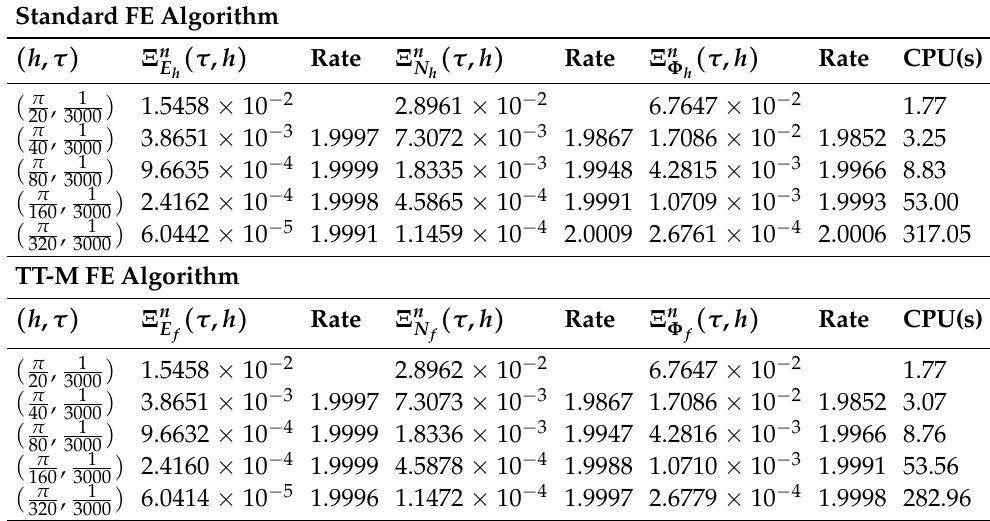
Table 1. Space convergence results for Example 1 with τ C = 4 τ .